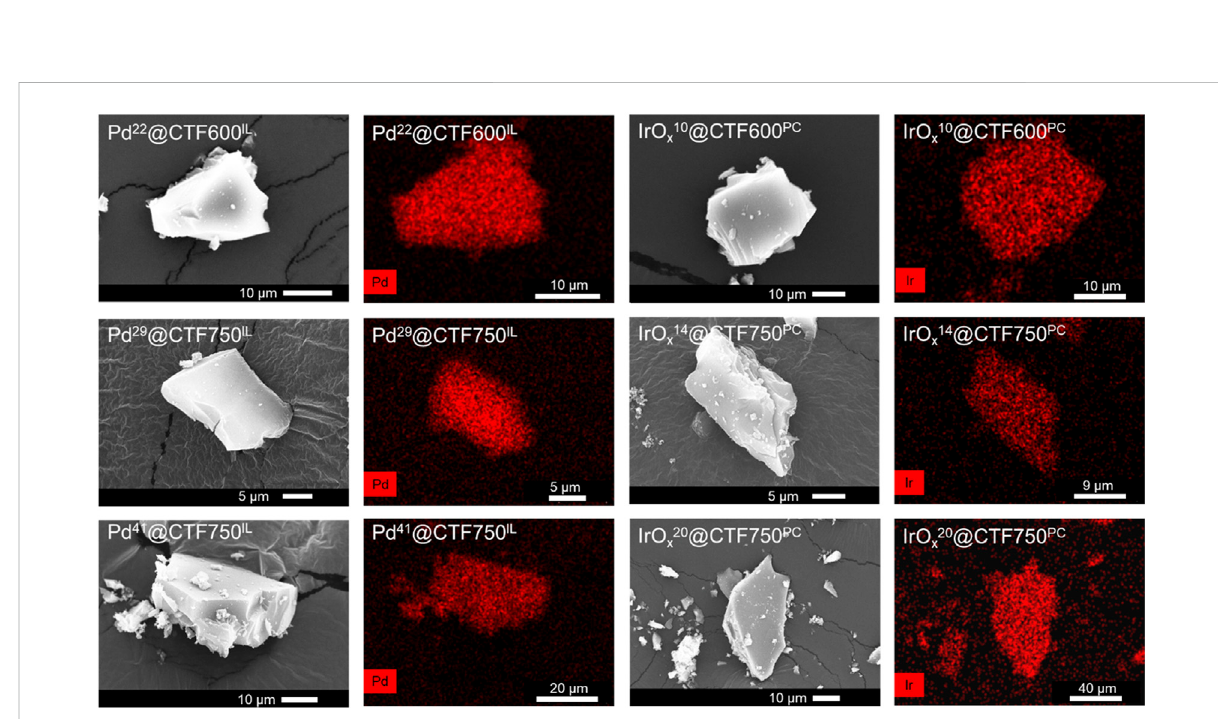
FIGURE 4 SEM images and EDX Pd and Ir mappings (in red) for Pd- and IrO x @CTF